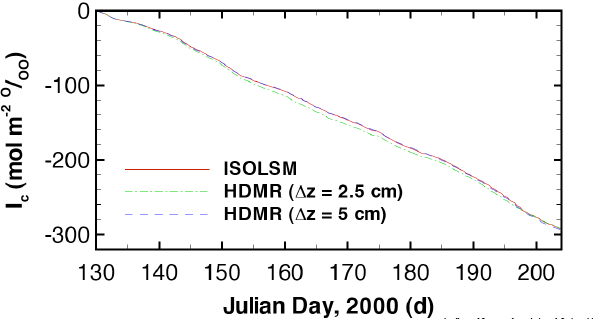
Fig. 4. Cumulative soil-surface isoflux calculated with ISOLSM and Figure 4. Cumulative soil-surface isoflux calculated with ISOLSM and the HDMR 7 the HDMR approach using discretization scenarios D 1 and D 2 . The approach using discretization scenarios D 1 and D 2 . The error in cumulative isoflux over 8 error in cumulative isoflux over the season for each HDMR scenario the season for each HDMR scenario is about 0.2% (0.5 mol m -2 ‰). 9 is about 0.2% (0.5molm − 2